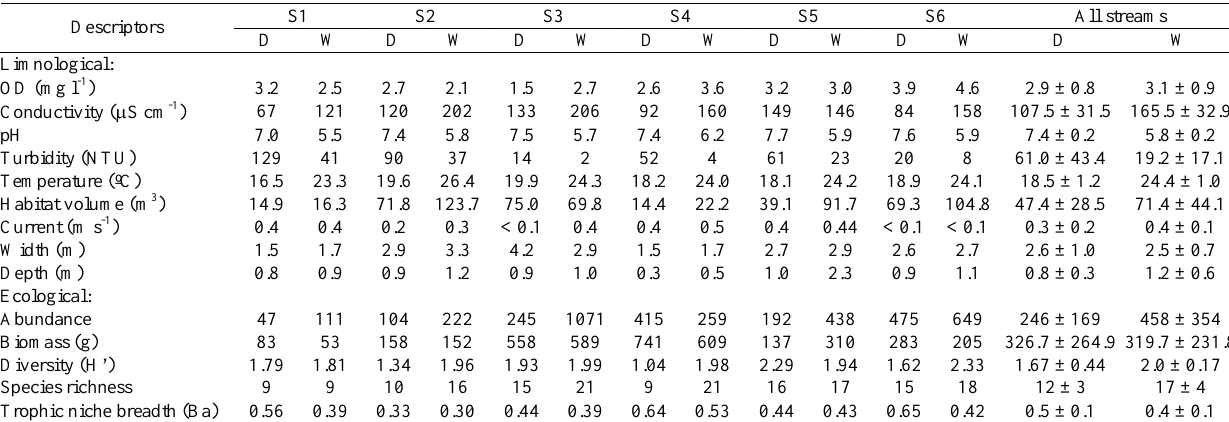
Table 2. Values of limnological (average) and ecological (absolute) descriptors of six stream stretches in the upper rio Turvo basin sampled during the dry period (D) and wet (W). All streams values are represented by mean and standard